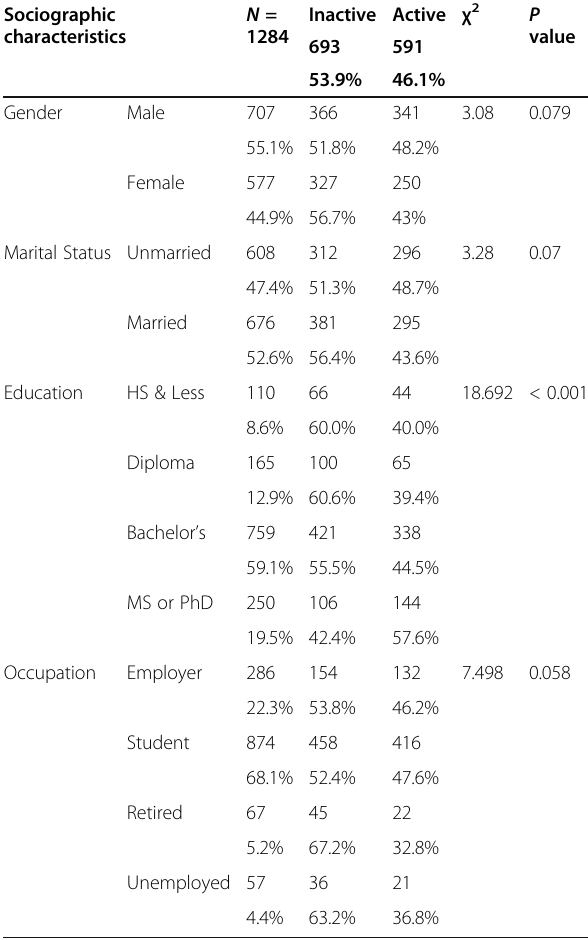
Table 1 Sociodemographic characteristics stratified by physical activity (PA) status during the outbreak of COVID-19 in Kuwait Sociographic